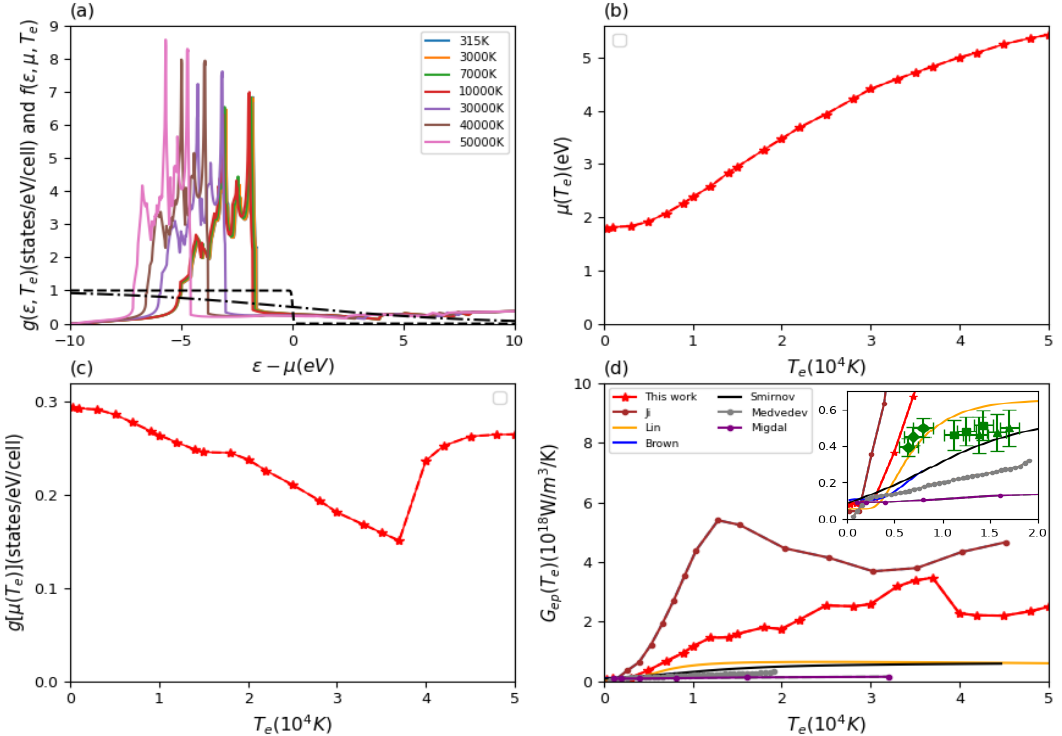
Figure 5. Results for copper. ( a ) Electron density of states g ( ε , T e ) with increasing electron temperature and Fermi distribution function f ( ε , µ ( T e ) , T e ) (dashed lines) for two electron temperatures at 315 K and 50000 K; ( b ) chemical potential µ ( T e ) and ( c ) electron density of states at chemical potential g [ µ ( T e )] as a function of electron temperature; ( d ) electron temperature-dependent electron–phonon coupling factor G ep ( T e ) , compared with various theoretical calculations.The available theoretical data are estimated by Lin et al. [44], Migdal et al. [52], Ji et al. [51], Brown et al. [48], Smirnov [53], and Medvedev et al. [49]. The green crosses are experimentally extracted values by Cho et al. [75]. The room temperature ( T e = 315 K) value is 8.31 × 10 16 W/m 3 /K and agrees